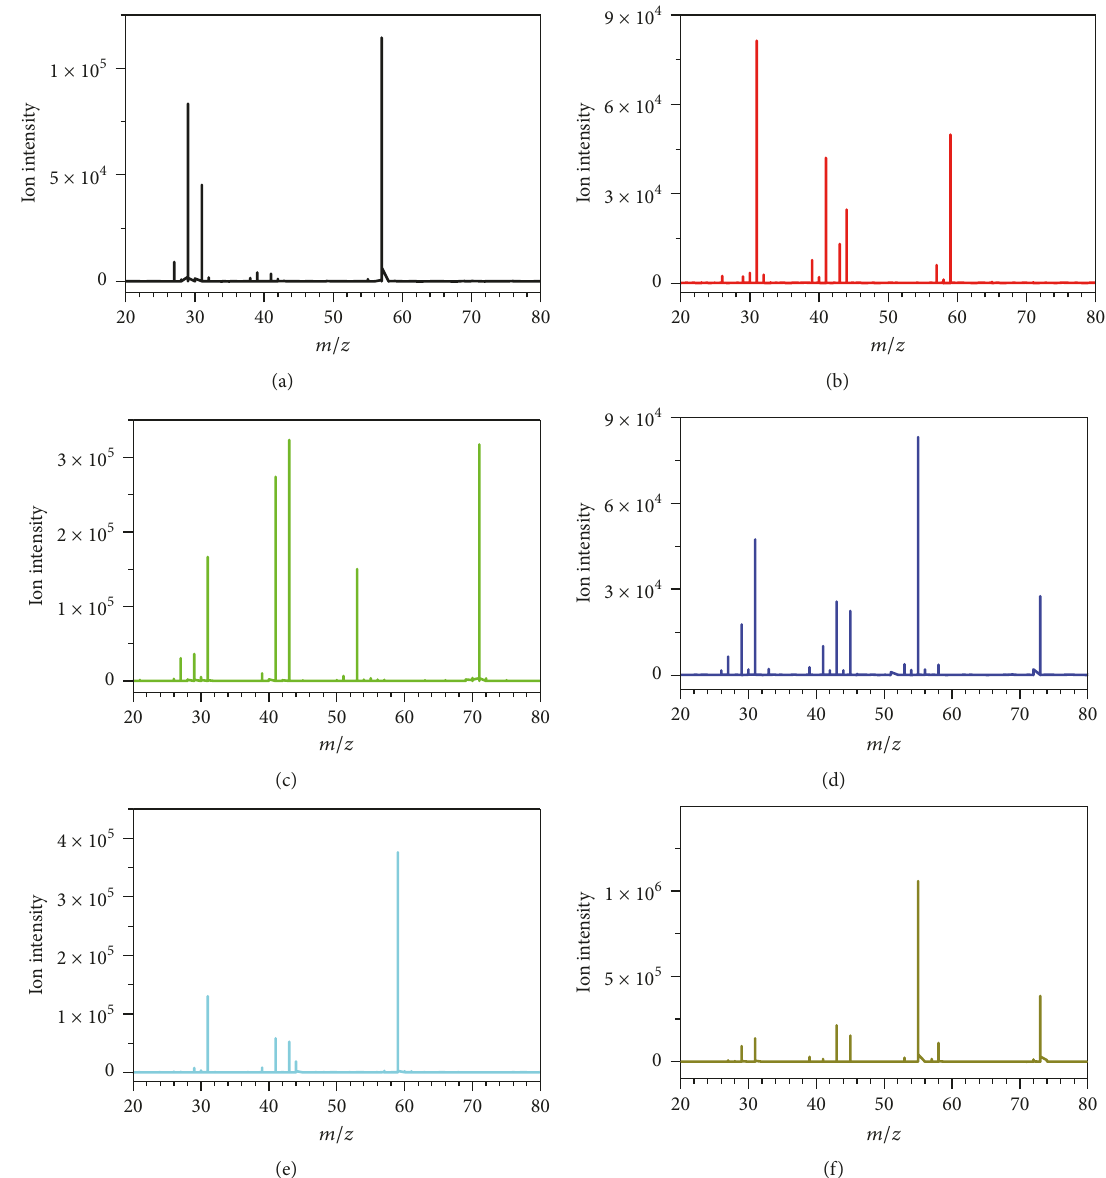
Figure 3: Daughter scan mass spectra of six low molecular carbonyl compounds with 0.5 𝜇 g/L under the CID energy of 15 eV. (a) Acrolein, (b) propionaldehyde, (c) crotonaldehyde, (d) butyraldehyde, (e) acetone, and (f) butanone.